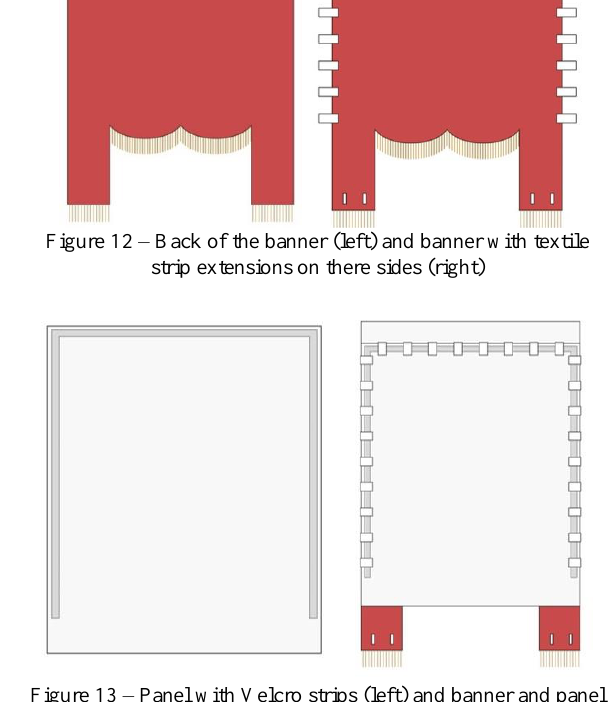
Figure 13 – Panel with Velcro strips (left) and banner and panel mounted together